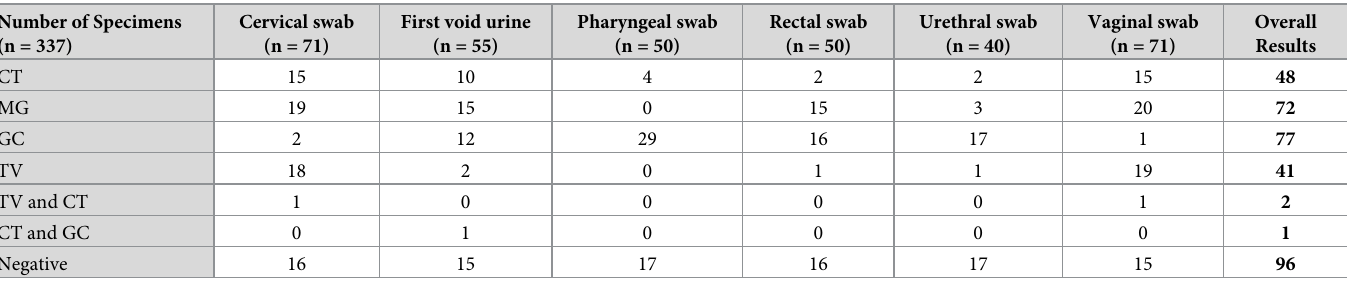
Table 2. Results reported for specimens analysed using the AllPlex ™ STI essential assay as part of routine screening. Number of Specimens (n =